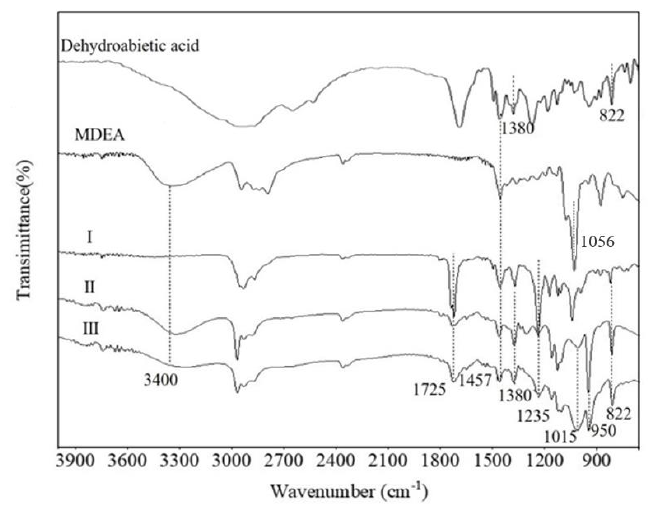
Figure 2. FT − IR of raw materials and productions I (DDAM), II (DPM) and III Figure 2. FT−IR of raw materials and productions Ⅰ (DDAM), Ⅱ (DPM) and Ⅲ (DPD).